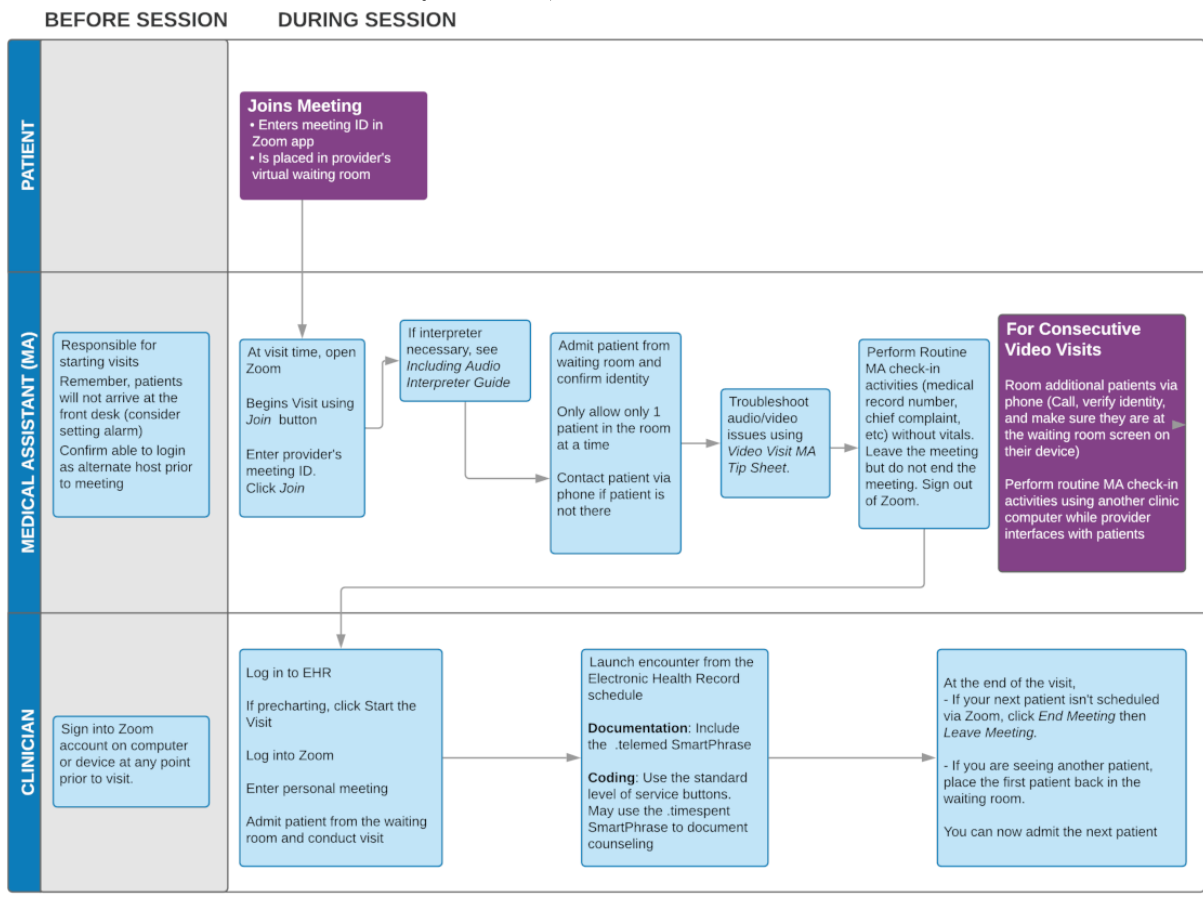
Figure 1. Video visit workflow used at the University of California, San